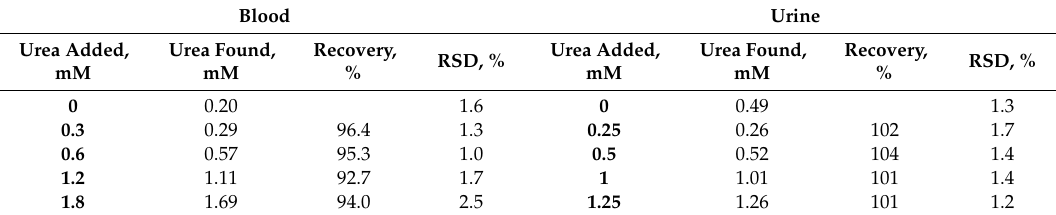
Table 3. Analytical performance of the proposed amperometric TRGO-based urea biosensor in blood and urine samples (n = 3). The standard addition method was applied. The first line represents the initial concentration of urea in blood or in urine. Other lines—di ff erence of urea concentration after addition of urea. Blood